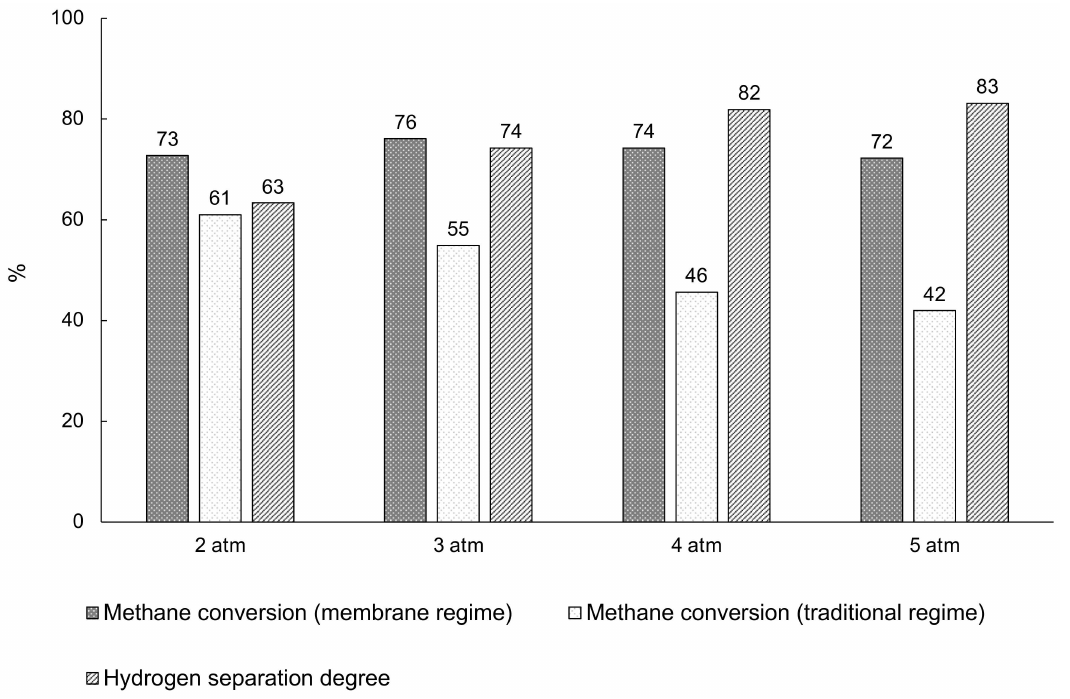
Figure 7. Dependences of methane conversion upon carbon dioxide reforming and degree of extraction of ultrapure hydrogen on the total pressure in the system in the membrane and tradi- tional